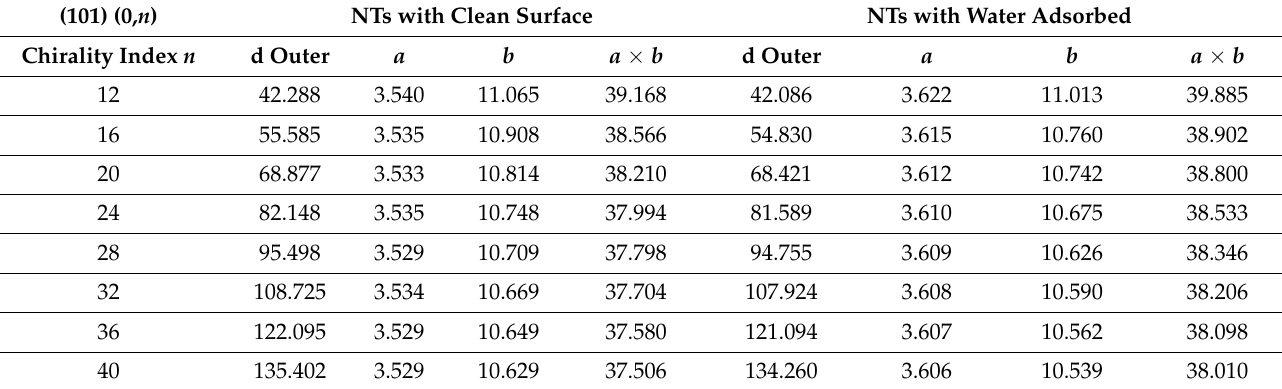
Table 2. Parameters of 6-layered (101) (0, n ) TiO 2 NTs, simulated with and without water. The lattice parameter correspond- ing to the NT axis is denoted with a , d stands for outer diameter, b —for outer b constant along NT circumference, and a × b —their product.